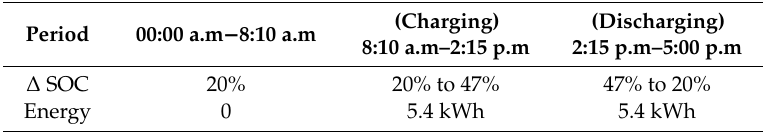
Figure 16. State of Charge (SOC) of BES of during the day hours. The operation of the FC during the day hours is shown in Figure 17 with/without the optimization of FLEMS using ABC algorithm. Before 8:00 a.m, it is noticeable that the operation of FC without optimization exceeds the total load demand need. This means that there is extra energy generated for no use due to the control of unoptimized FLEMS, hence, the total generation cost increased. On the other hand, the operation of FC controlled by optimized FLEMS is decreased and almost covered the load demand during the absence of REG and BES. In addition, after 8:00 p.m, the operation of FC using unoptimized FLEMS gives nearly the same load demand although the REG still generating power; most probably from WT due to moderate wind speed at that time (see Figure 13) this means there is an extra unused power generated from FC leads to increase in generation cost. However, the operation of FC controlled by optimized FLEMS generates almost the needed power for the load demand after the consumption of REG power, thus it appeared lower than load demand power in the graph. For the purpose of simplifying the simulation, the starting time of FC is neglected. Total energy analysis details of the proposed microgrid during the operation in the day hours are presented in Table 5. Depending on the amount of energy that the microgrid should be supplied from backup systems during the day hours, system energy saving efficiency is calculated before and after optimization.